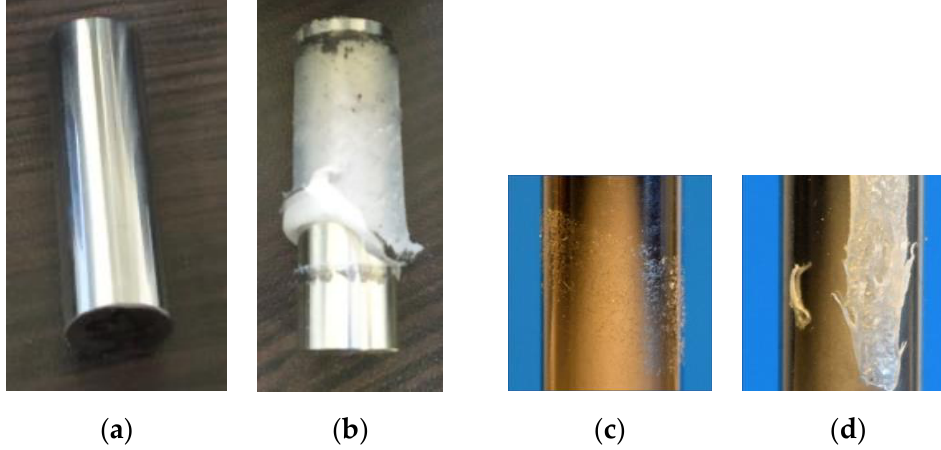
Figure 5. Metal substrates after strength test: ( a ) clean rod; ( b ) intact layer from treated polymer; ( c ) hair-like plastic residue; ( d ) clean area and extensive plastic residue.